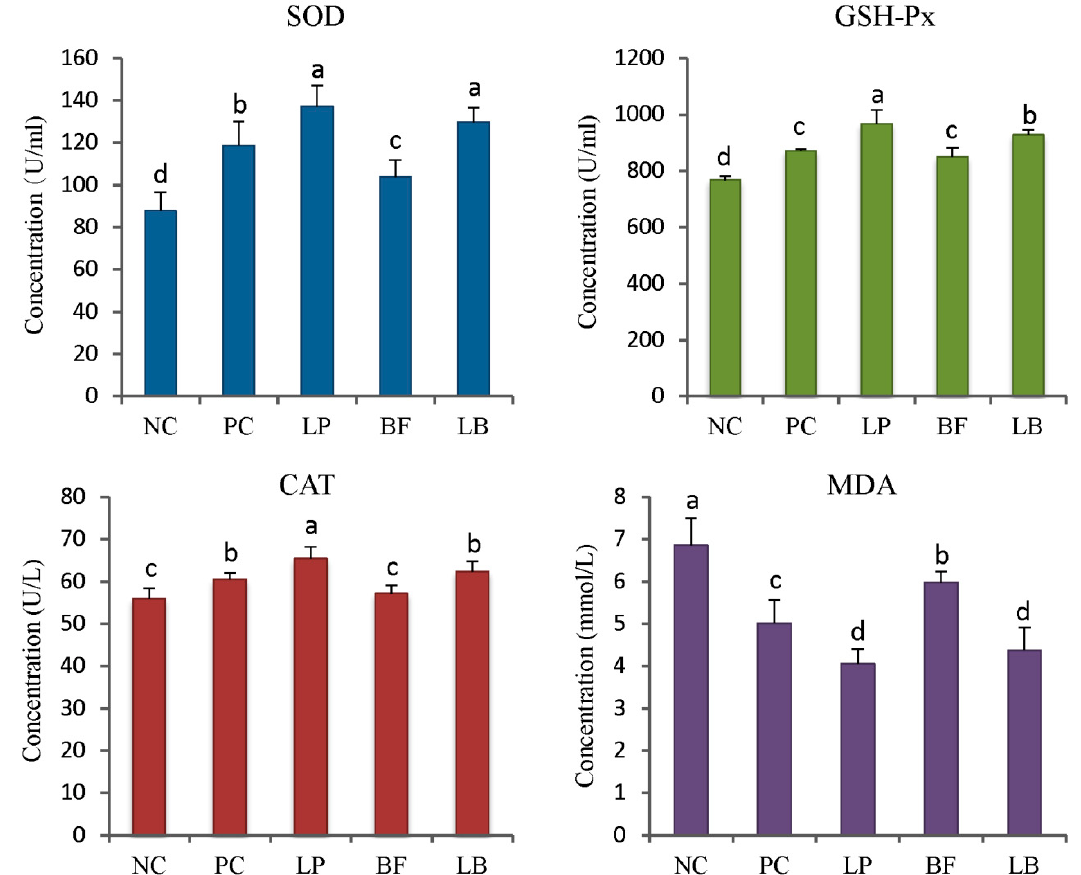
Figure 1. E ff ects of L. plantarum , tartary buckwheat flavones, and their combination on the activities of antioxidant enzymes of weaned piglets. SOD: Superoxide dismutase; GSH-px: Glutathione peroxidase; CAT: Catalase; MDA: Malondialdehyde.